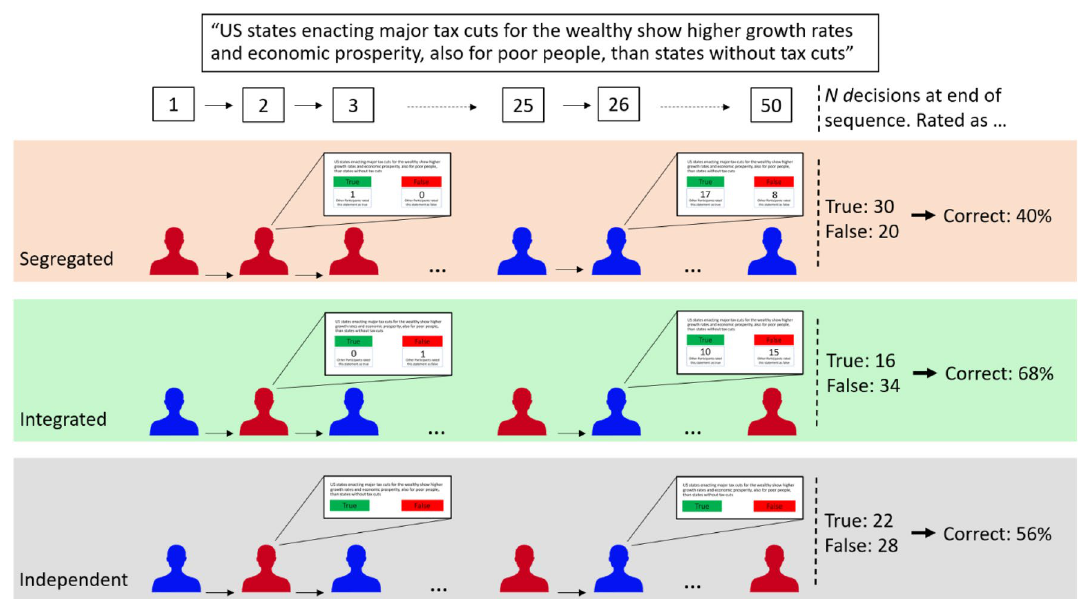
Figure 1. Study setup. Subjects were randomly assigned to ideologically segregated, ideologically integrated, or independent groups and instructed to rate 20 informational messages as true or false. Subjects rated messages sequentially. In segregated and integrated groups, subjects were presented a count of previous group members’ rating decisions. Subjects in independent groups made rating decisions without being exposed to previous subjects’ decisions. Red (blue) icons represent self-identified conservatives (liberals). The example message in the figure is false and has a conservative leaning. For each rating group, we measured how many correct and incorrect rating decisions were made (right side of the figure, data taken from exemplary groups observed in the experiment). We collected data from 80 rating groups with 50 subjects each, amounting to a total of 80,000 rating